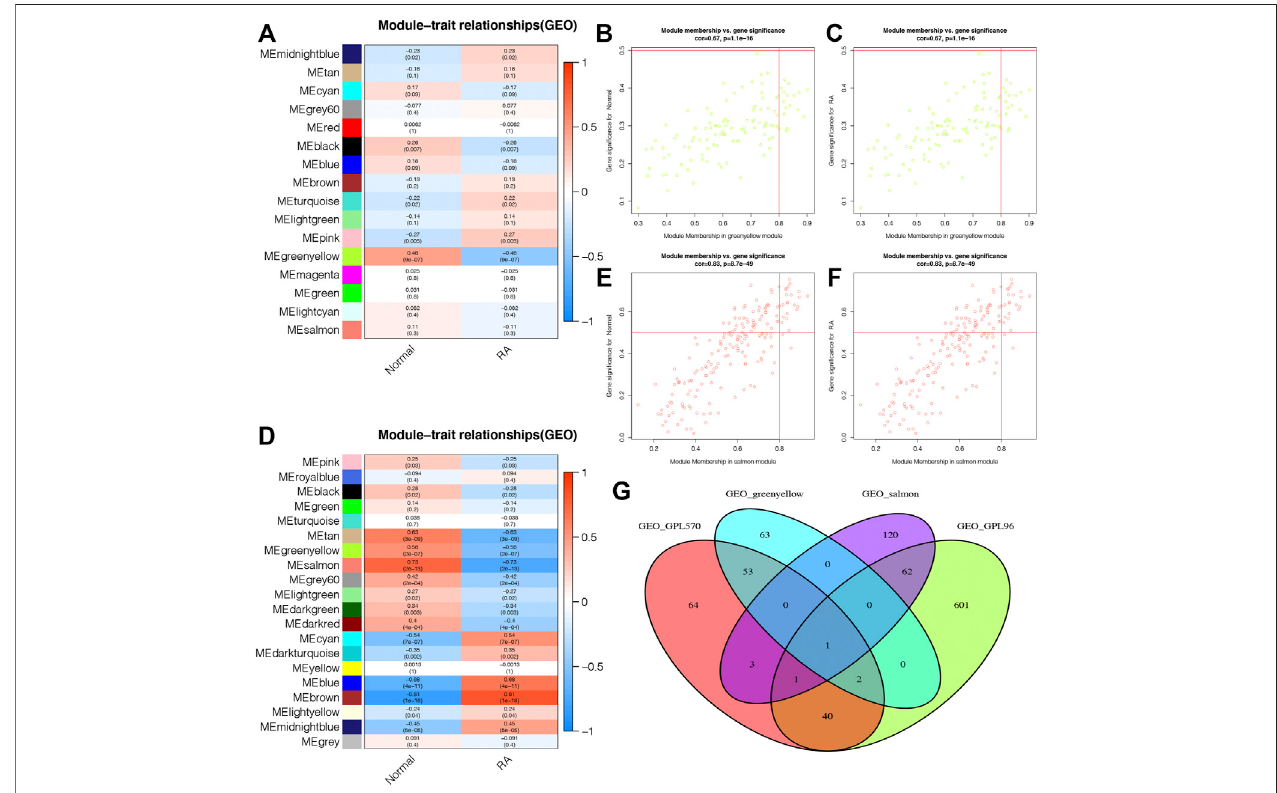
FIGURE 5 | The selection of potential biomarkers based on the most correlated gene modules and differentially expressed genes. (A and B) The module – trait relationship plots shows that ME-greenyellow module and ME-salmon module were the most correlated gene modules in the GPL570 and GPL96 databases, respectively. The genes in the ME-greenyellow module and ME-salmon module had a signi fi cant correlation with normal and rheumatoid arthritis (RA) samples in the GPL570 (C and D) and GPL96 databases (E and F) . (G) TheME-greenyellow module genes, theME-salmonmodule genes, and differentially expressed genes in the GPL570 and GPL96 databases were intersected to screen out fi nal potential biomarkers.